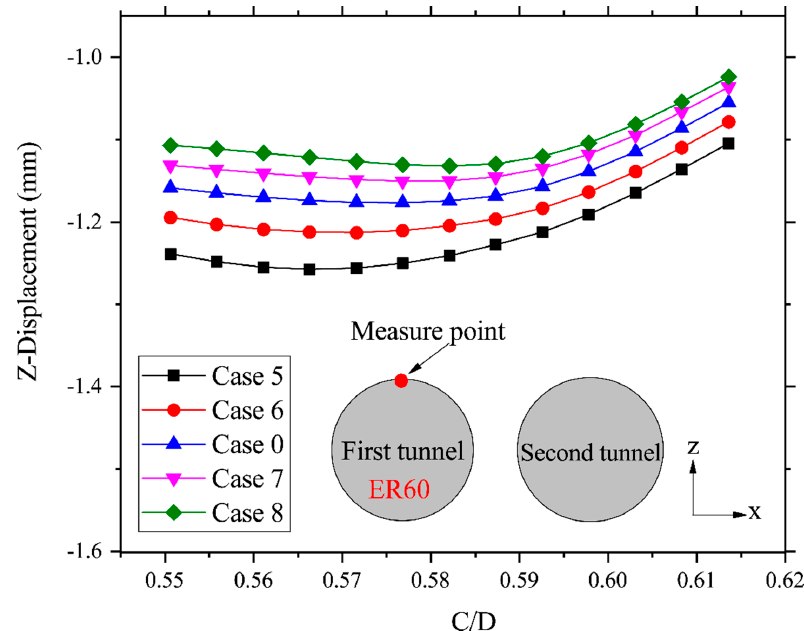
Figure 11. Vertical displacement of the lining under di ff erent supporting pressures.